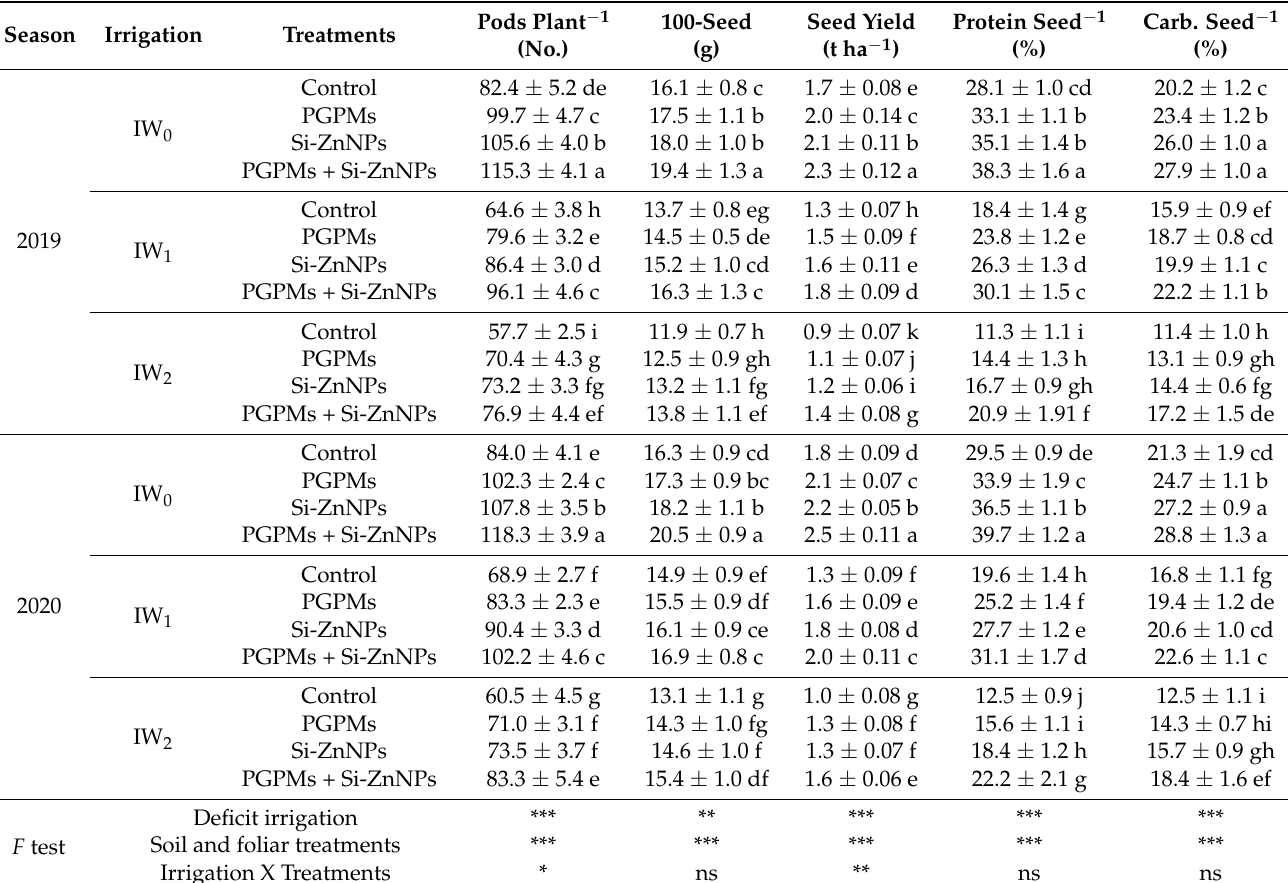
under IW 2 , the seed yield decreased by 16.8% below the control of IW 0 . The same trends were observed for pods number per plant and 100 seeds weight. Table 1. Characteristics of yield and seed nutritional quality of soybean plant treated with PGPMs and/or Si-ZnNPs, and grown in salt-affected soil with different levels of watering intervals ( IW 0 ; 11 days, IW 1 ; 15 days, and IW 2 ; 19 days)